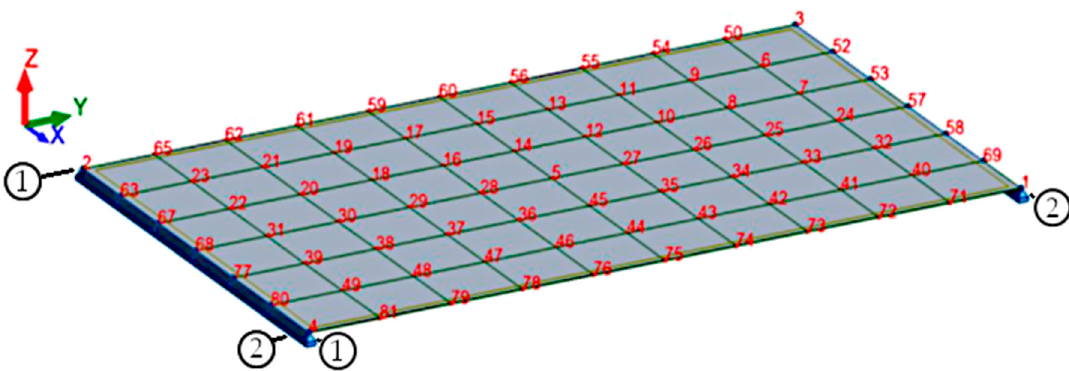
Figure 7. The numerical model of the slab element.